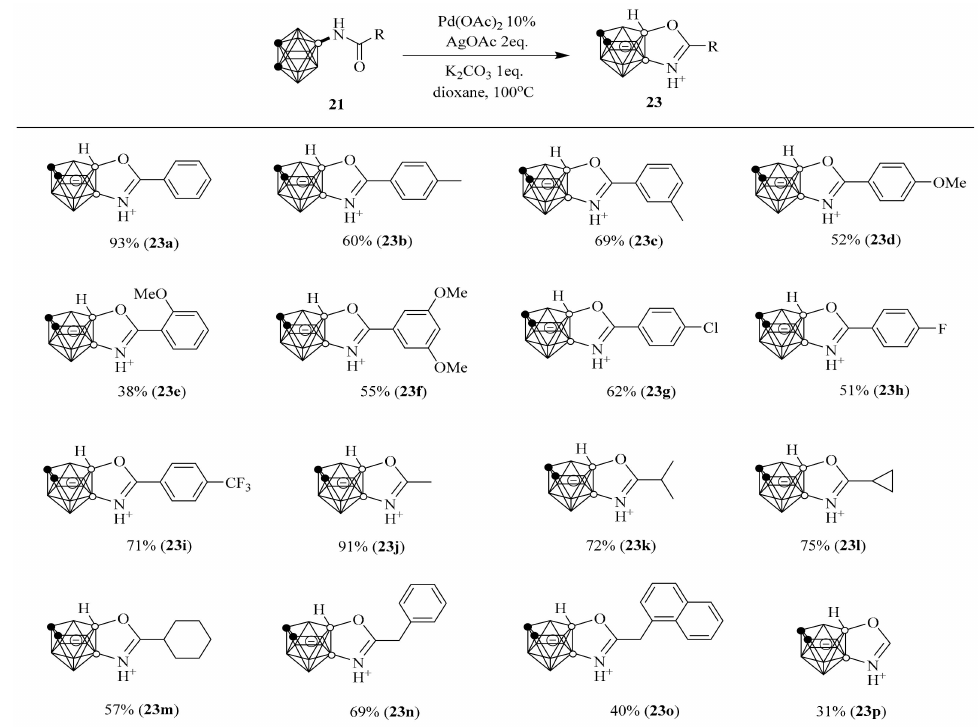
Figure 8. Synthesis of nido -7,8-carborane-fused